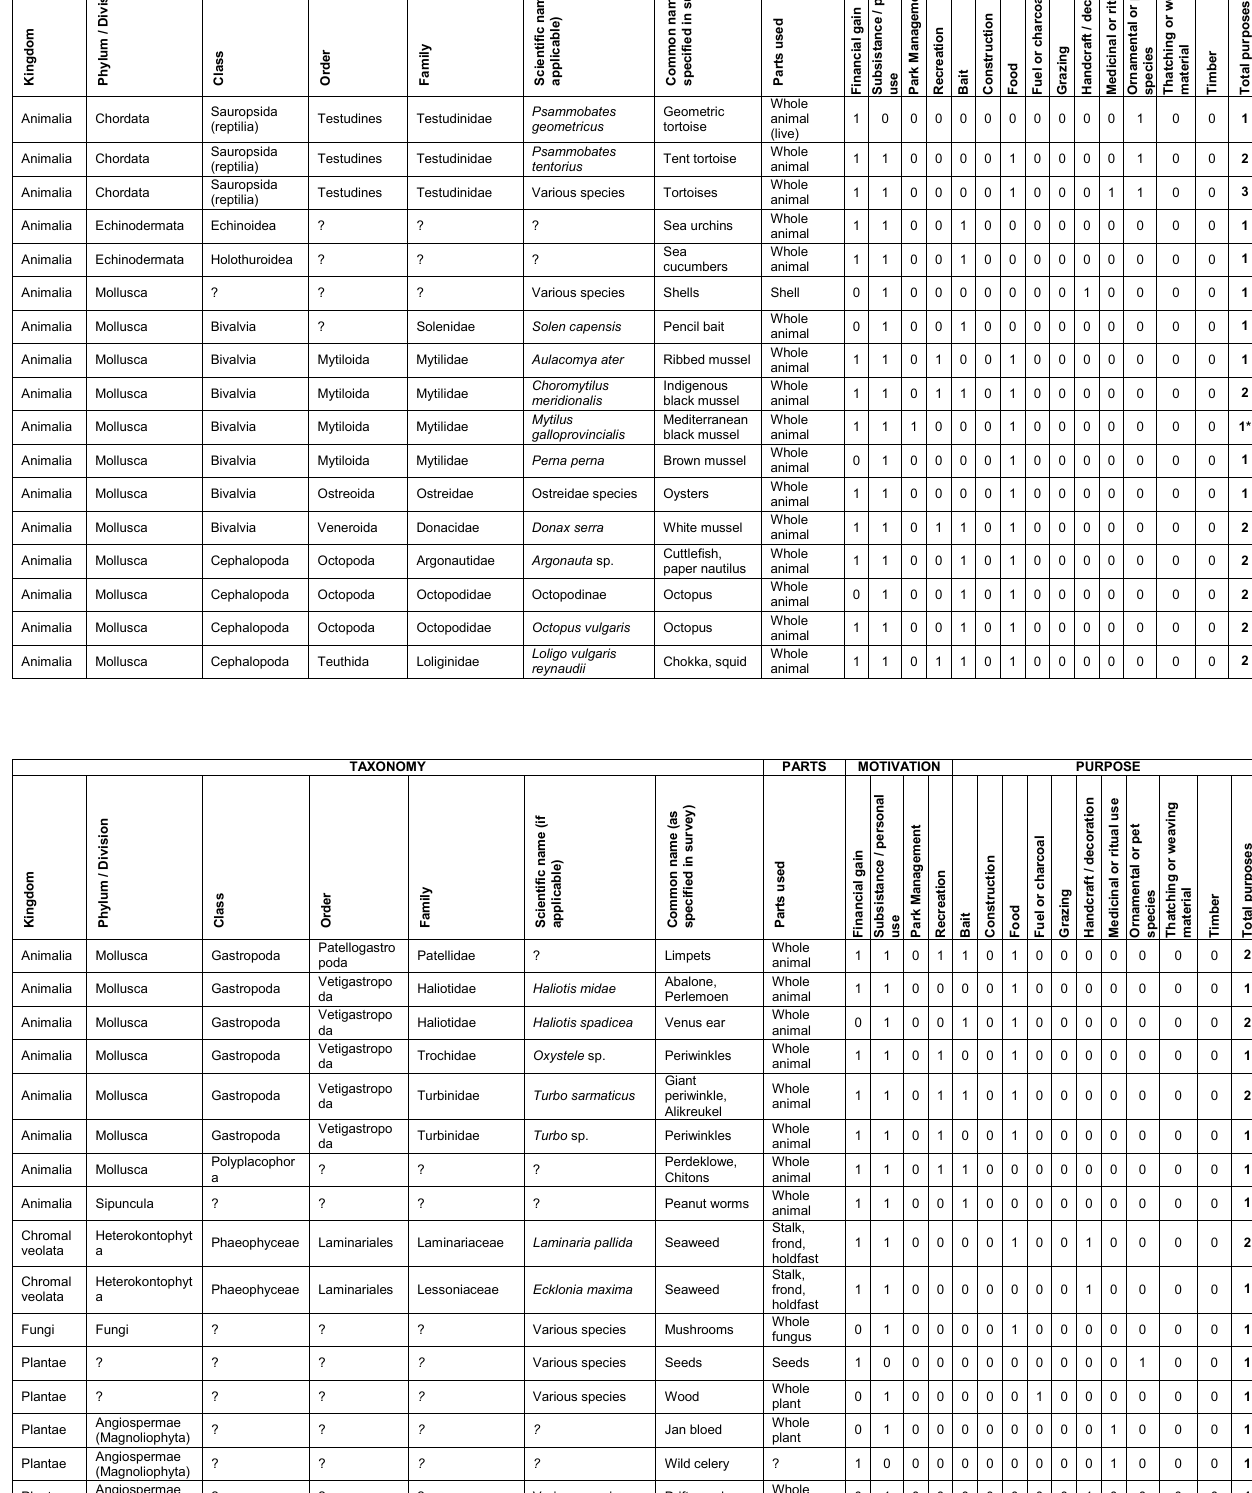
? ? ? Various species Mushrooms Whole fungus ? ? ? ? Various species Seeds Seeds 1 0 0 0 0 0 0 0 0 0 0 1 1 ? ? ? ? Various species Wood Whole plant ? ? ? Jan bloed Whole plant ? ? ? Wild celery ? ? Various species Drift wood Whole pieces 0 1 0 0 0 0 0 0 0 1 0 0 ? ? Various species Sedges and reeds Whole plant? 0 1 0 0 0 0 0 0 0 1 0